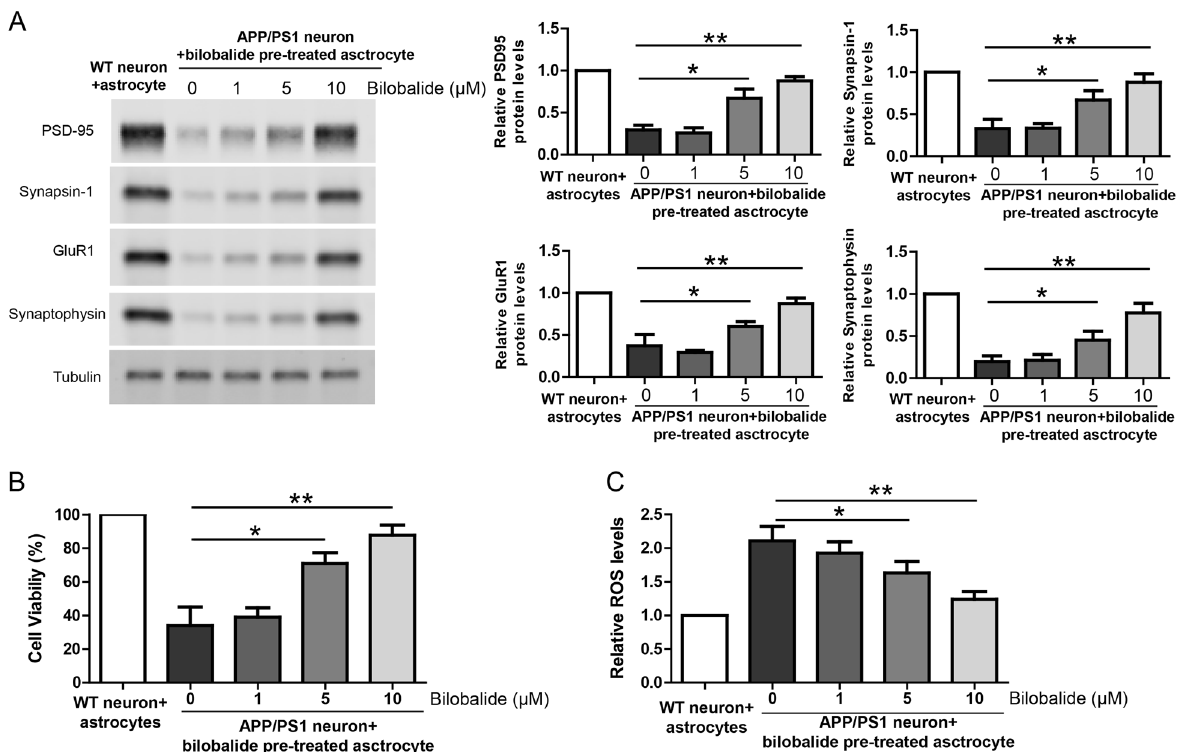
Fig. 4 Bilobalide rescues neuronal de fi ciency in astrocyte-APP/PS1 neuron co-cultures. A Western blot and its quanti fi cation showing the protein levels of PSD-95, Synapsin-1, GluR1, and Synaptophysin in the lysate of wild-type neuron or APP/PS1 neuron co-cultured with astrocyte pretreated with Bilobalide. B CCK-8 assay showing neuronal viability of wild-type neuron or APP/PS1 neuron co-cultured with astrocyte pretreated with Bilobalide. C ROS levels in the lysate of wild-type neuron or APP/PS1 neuron co-cultured with astrocyte pretreated with Bilobalide. * P < 0.05, ** P < 0.01.